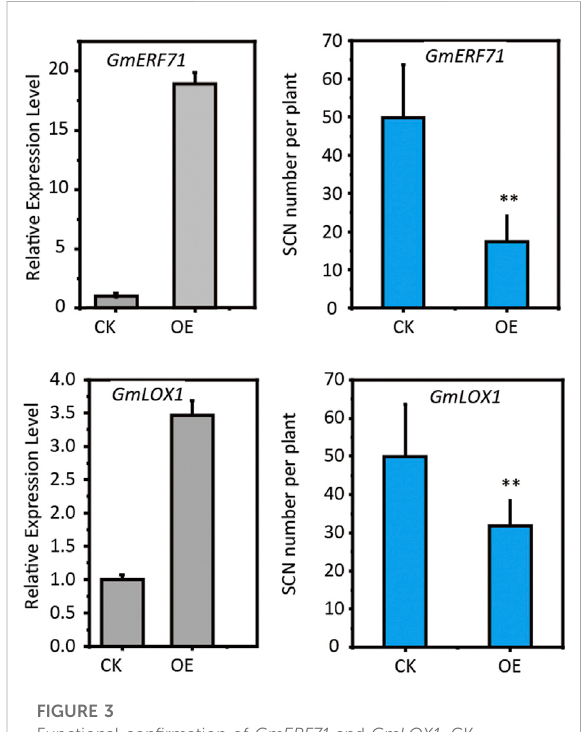
FIGURE 3 Functional con fi rmation of GmERF71 and GmLOX1 . CK, control; OE, plants with gene overexpressed. The signi fi cance was determined by t test. n =